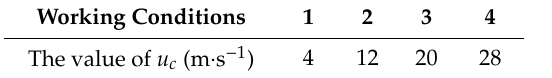
Table 4. Four di ff erent crosswind conditions. Table 4. Four different crosswind